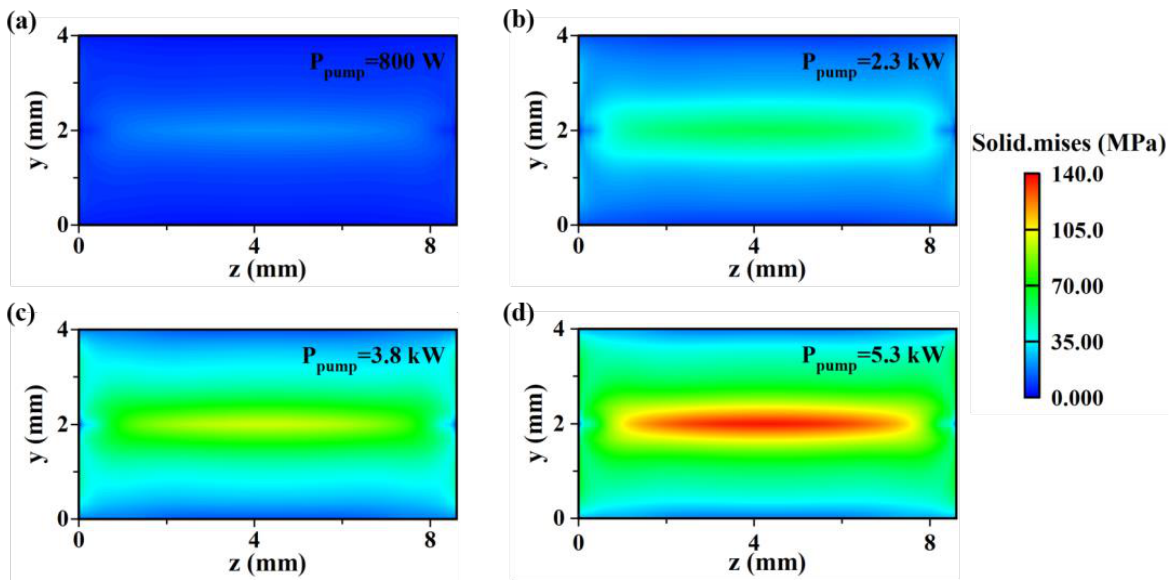
Figure 5. Cross-sectional thermal stress distribution of diamond crystal at different output power levels, ( a ) 800 W, ( b ) 2.3 kW, ( c ) 3.8 kW, and ( d ) 5.3 kW.